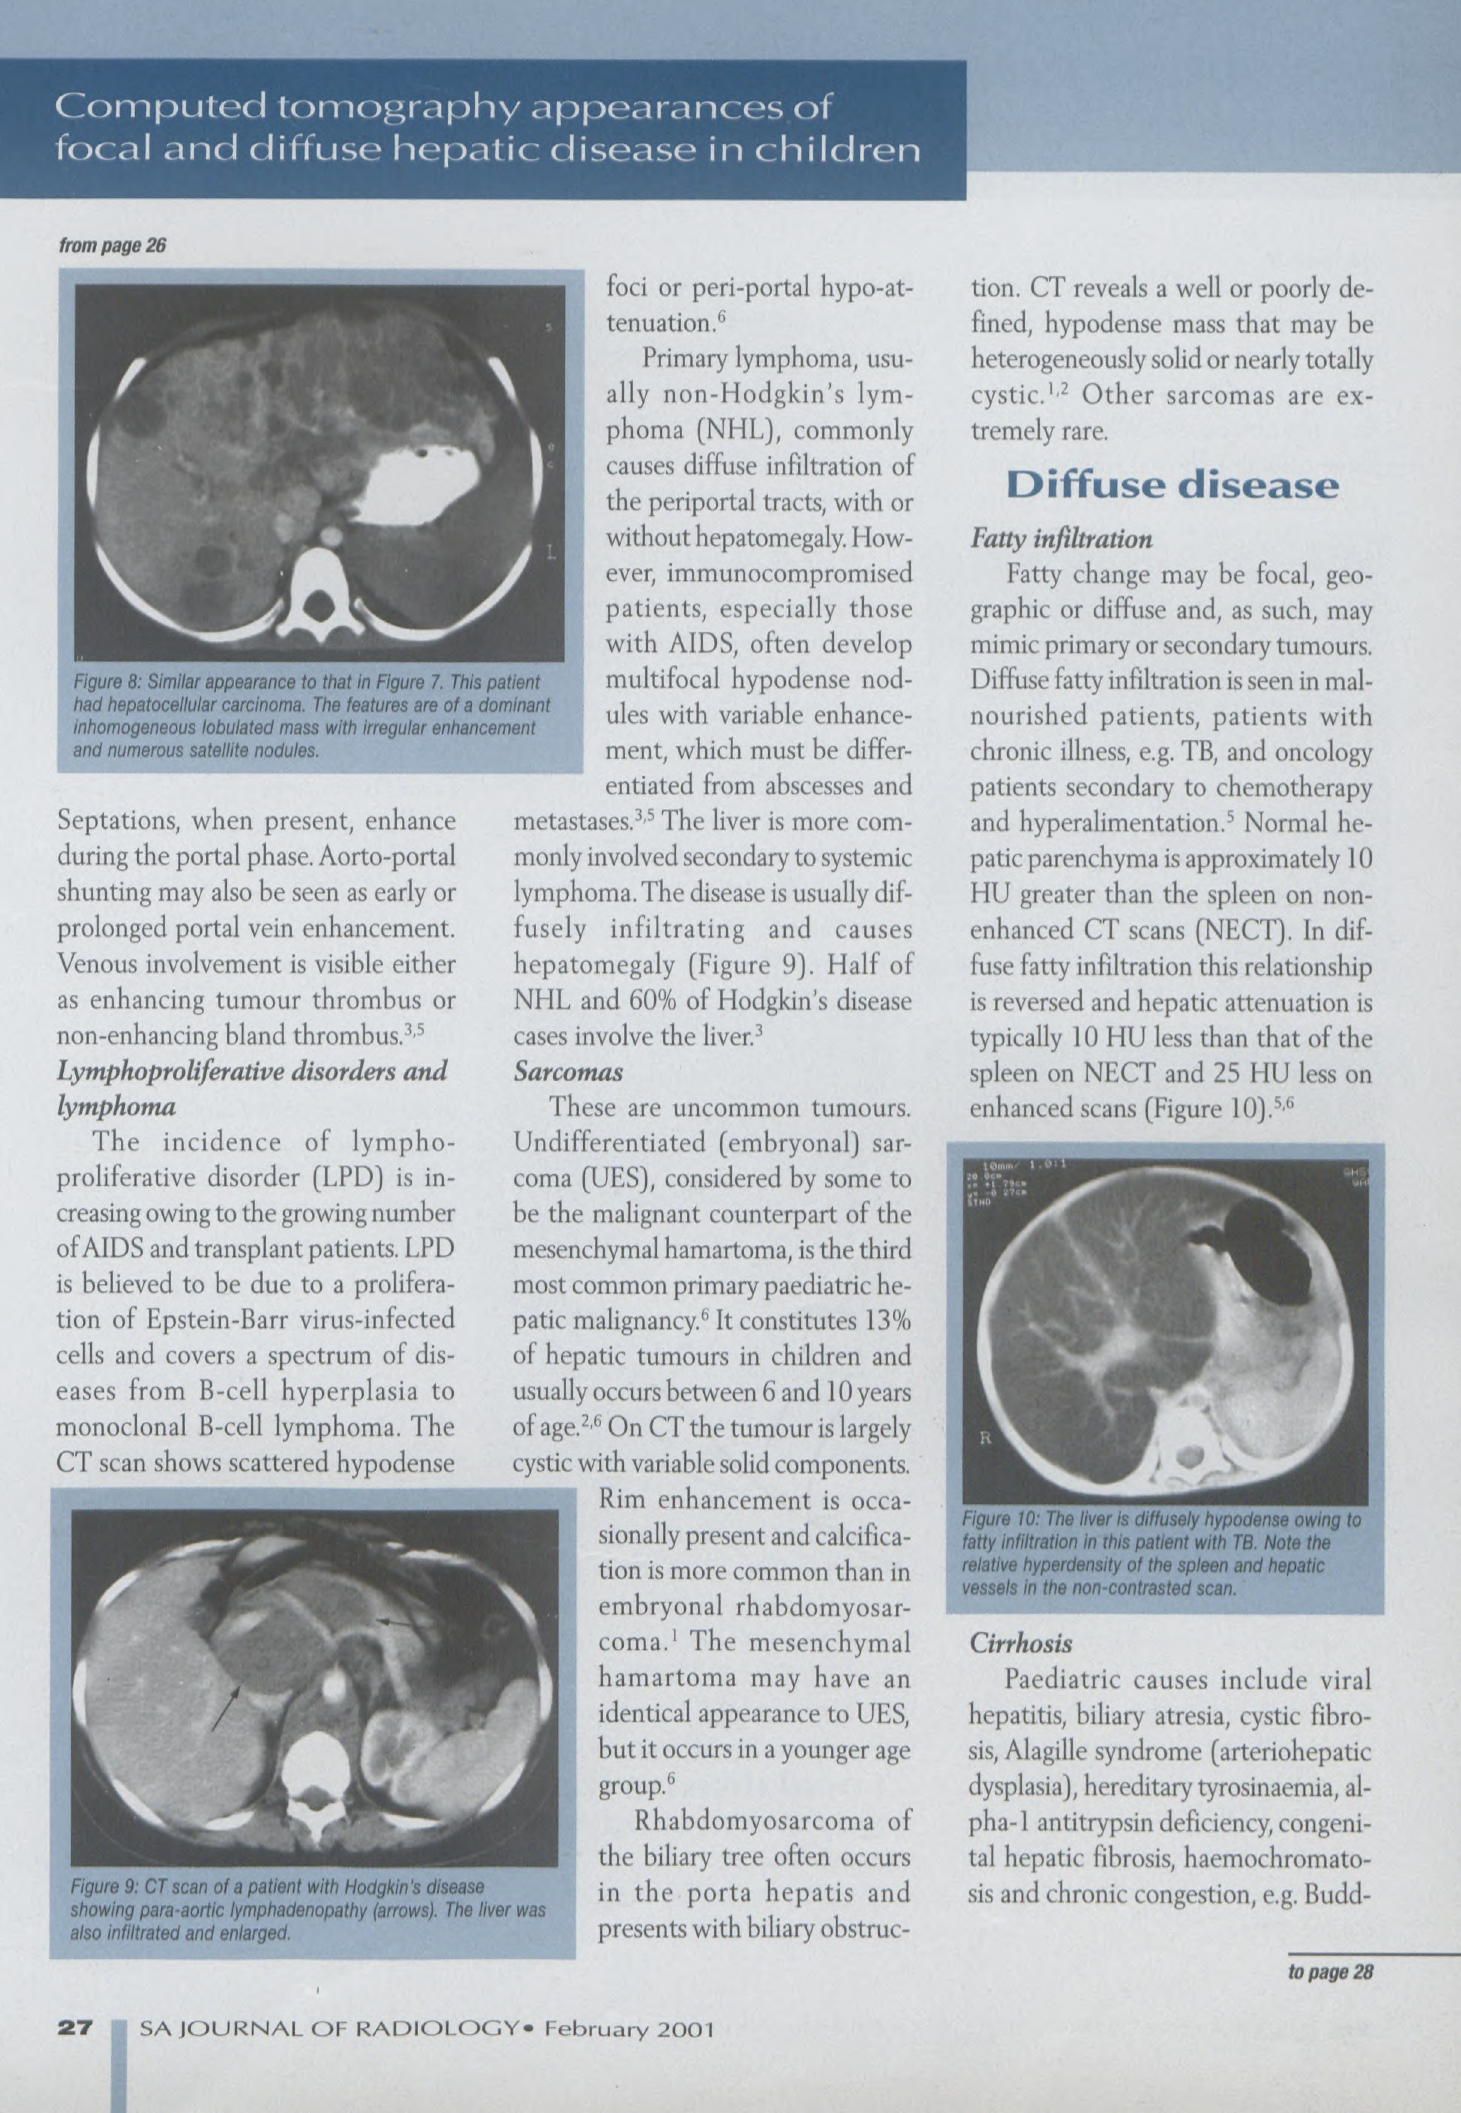
Figure 9: CT scan of a patient with Hodgkin's disease showing para-aortic lymphadenopathy (arrows). The liver was also Infiltrated and enlarged.